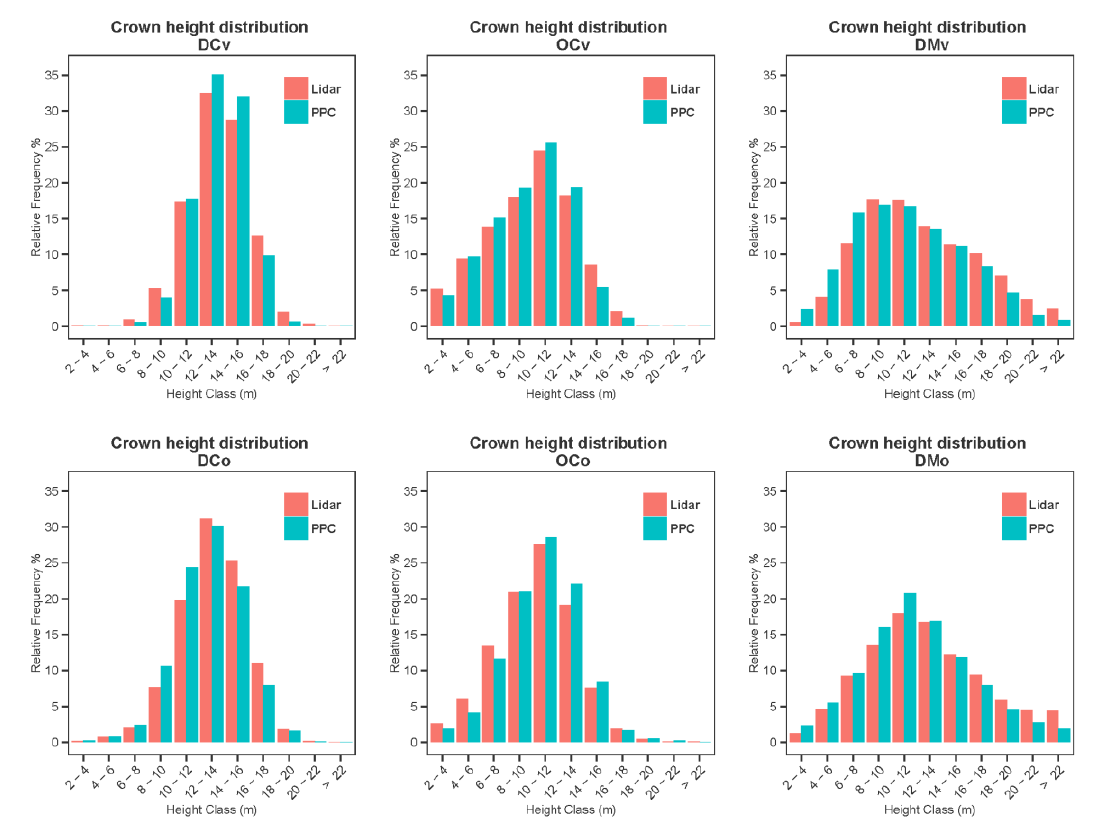
Figure 8. Relative tree height distributions derived respectively from lidar and